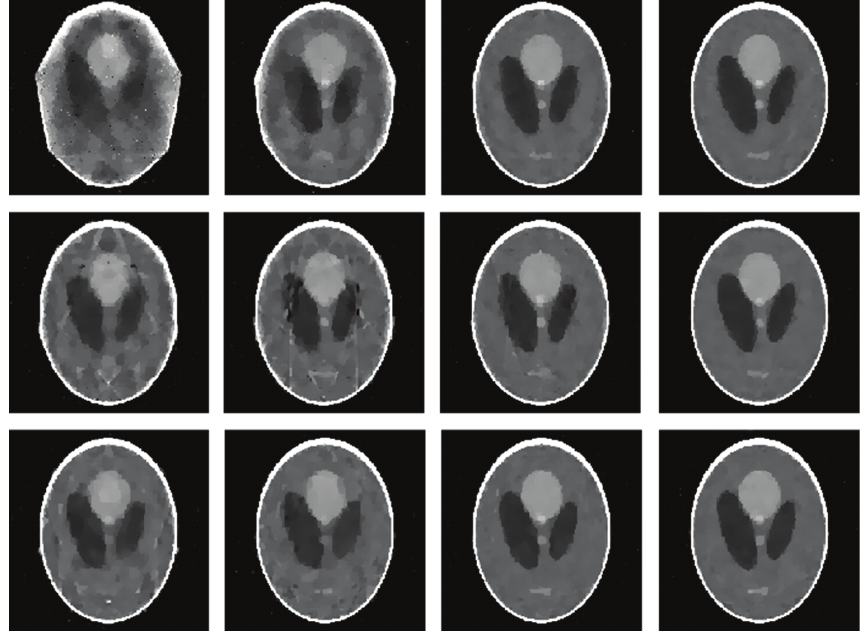
Figure 4: The counterparts of Figure 3 from datasets corrupted by Poisson